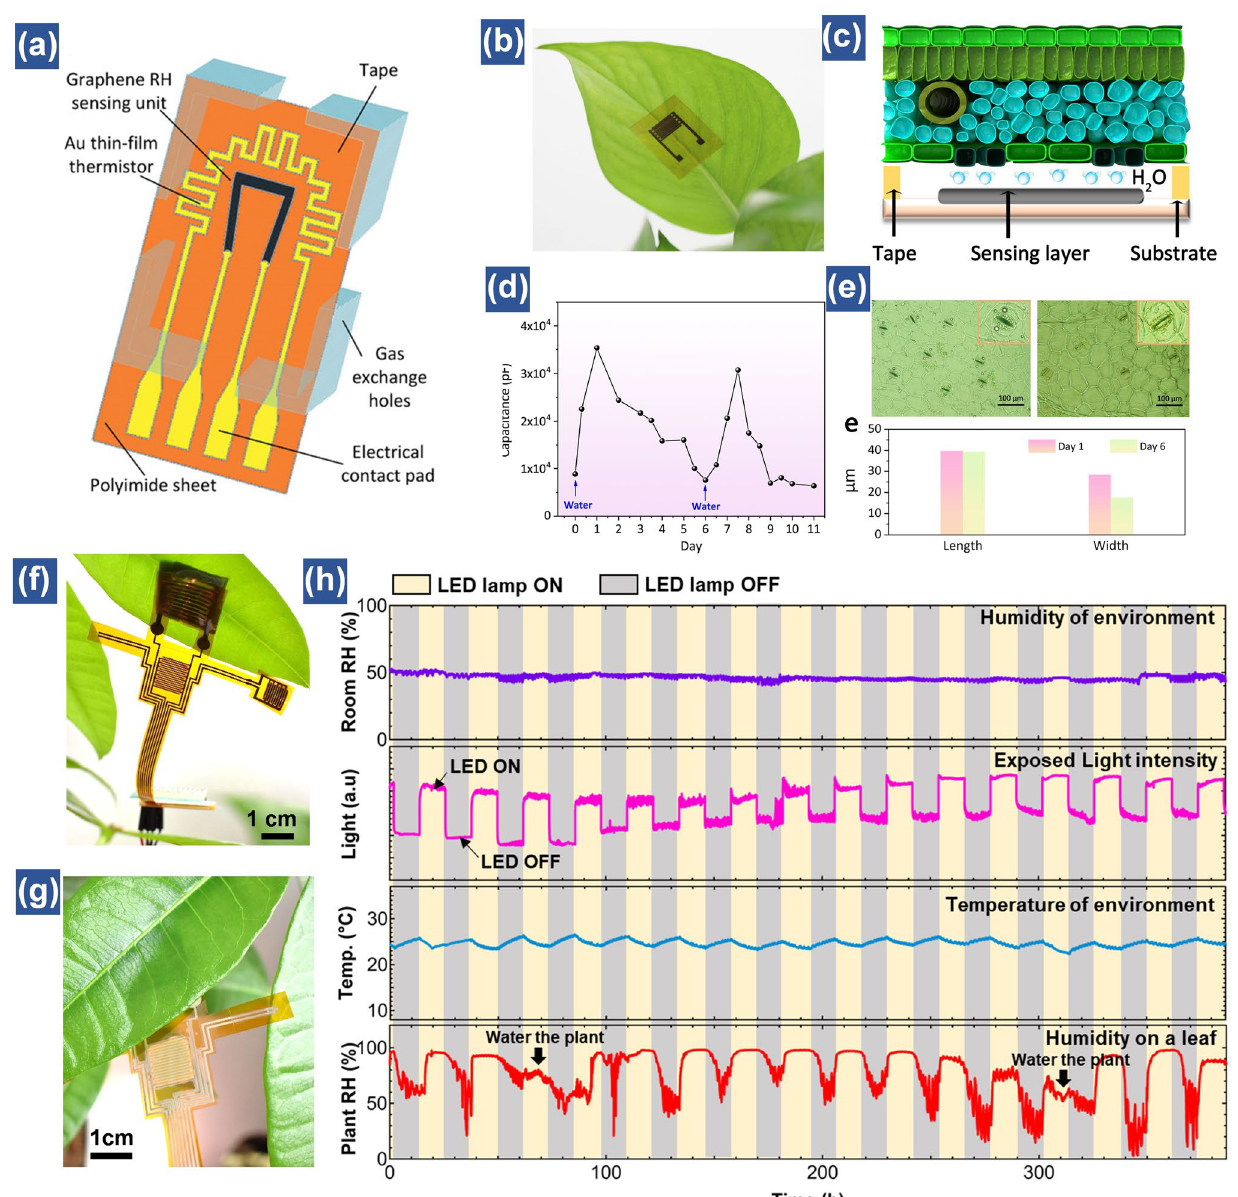
Fig. 11 Plant healthcare management. ( a ) Schematic of the integrated temperature and humidity sensor formed on a flexible substrate. The sen- sor consists of a gold thin-film based temperature sensor and a laser-induced graphene-based RH sensor [161]. Copyright 2021 Wiley. ( b ) Photo- graph of the GO-based humidity sensor attached to the lower surface of a leaf. ( c ) Schematic illustration of the cross-sectional inner structure of a leaf and the sensing mechanism. ( d ) Real-time monitoring of the capacitance response of the sensor to drought stress over time. ( e ) Images of stomata of the leaf after watering for 1 day (left) and 6 days (right) [98]. Copyright 2020 Elsevier. ( f–h ) Transpiration monitoring results using a multimodal flexible sensor device for over 350 h. Room humidity, light, room temperature, and leaf humidity results are shown from the top to bottom. Monitoring start date: August 08, 2019. Power of artificial light source is 18 W [44]. Copyright 2020 ACS